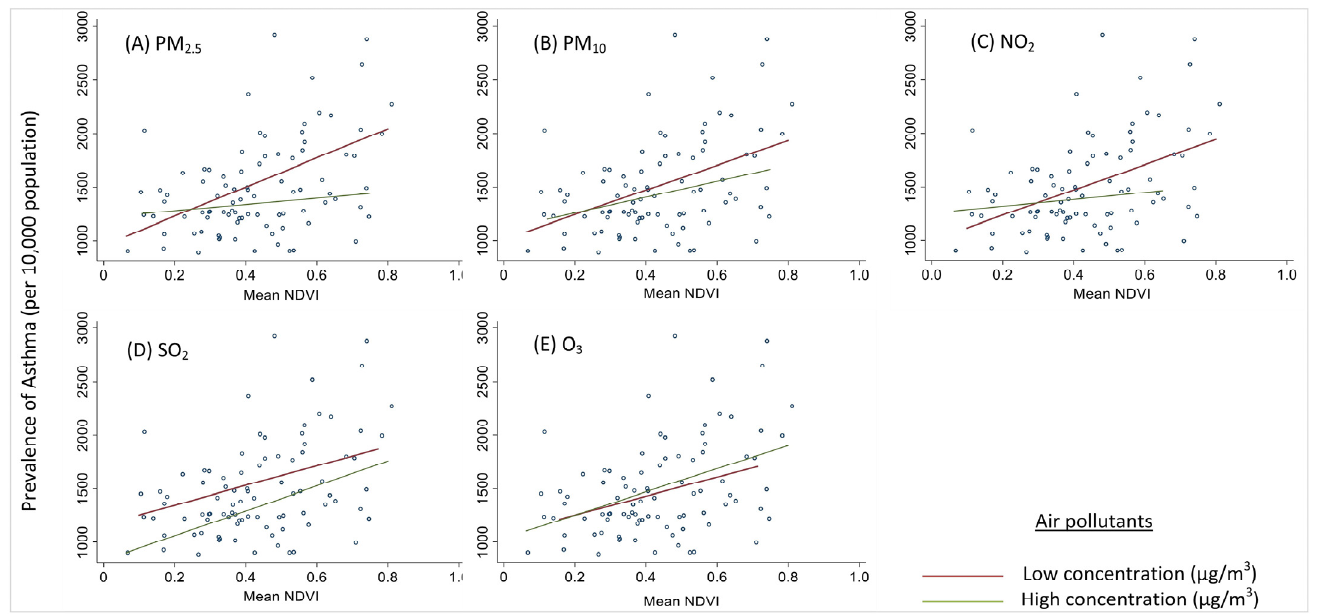
Figure 4. Interaction of the NDVI and air pollutants: ( A ) PM 2.5 , ( B ) PM 10 , ( C ) NO 2 , ( D ) SO 2 , and ( E ) O 3 , influencing the prevalence of asthma. The prevalence rates of asthma in children (0–19 years) in the SUTs are shown on the Y -axis with interactions with the mean NDVI ( X -axis) and low and high concentrations of air pollutants (A) PM 2.5 , (B) PM 10 , and (C) NO 2 in states in the top panel (left to right). The bottom panel represents the interaction of the mean NDVI ( X -axis) and high concentrations of air pollutants (D) SO 2 and (E) O 3 , represented along the vertical Y- axis, with the asthma prevalence rate. Note: NDVI, normalized differential vegetation index; PM 2.5 , particulate matter of diameter 2.5 µm or smaller; PM 10 , particulate matter of diameter 10 µm or smaller; NO 2 , nitrogen dioxide; SO 2 , sulfur dioxide; O 3 , ozone.